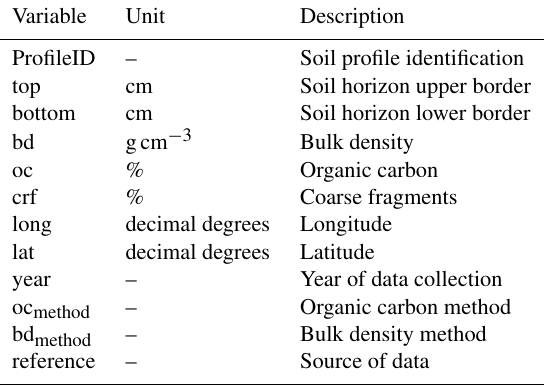
Table A1. Naming conventions and descriptions of variables provided in the Chilean Soil Organic Carbon database